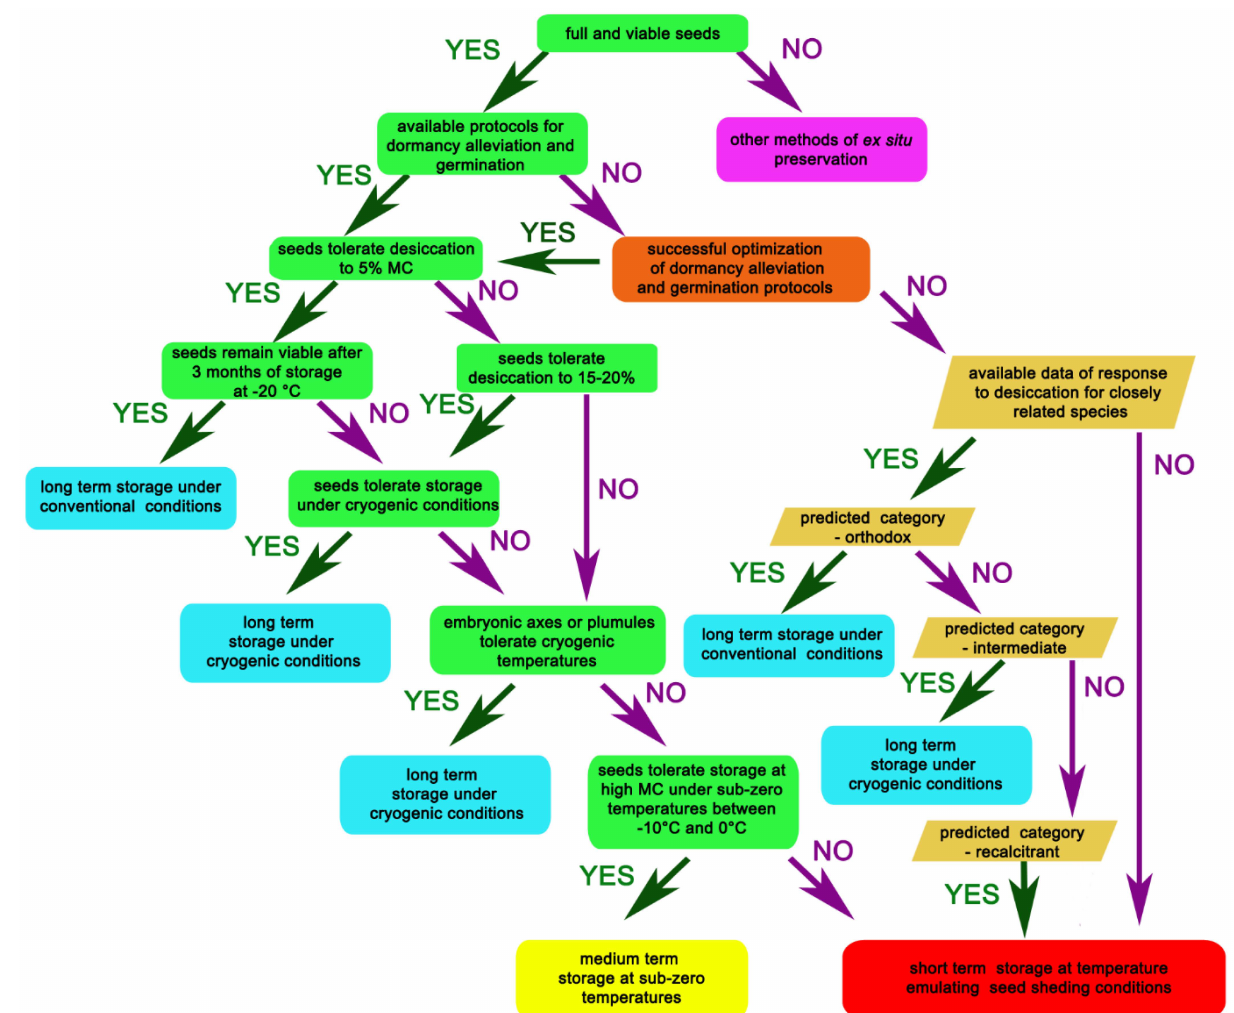
Figure 1. A protocol to determine the optimal conditions of plant germplasm storage. Two paths are presented: experimental in rectangles and literature based in